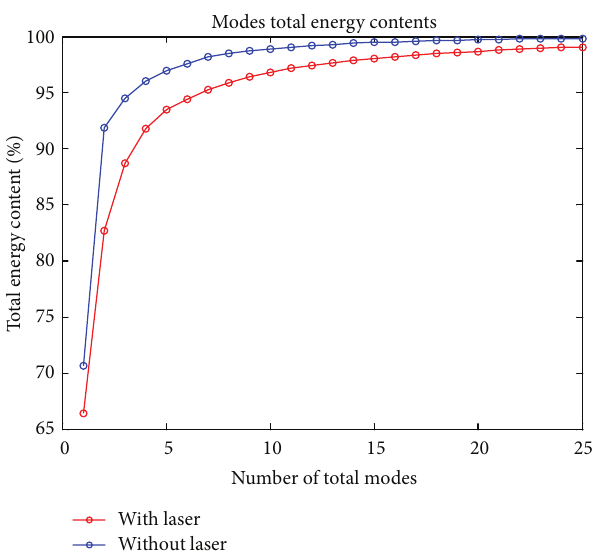
Figure 6: Total energy distribution of POD modes.